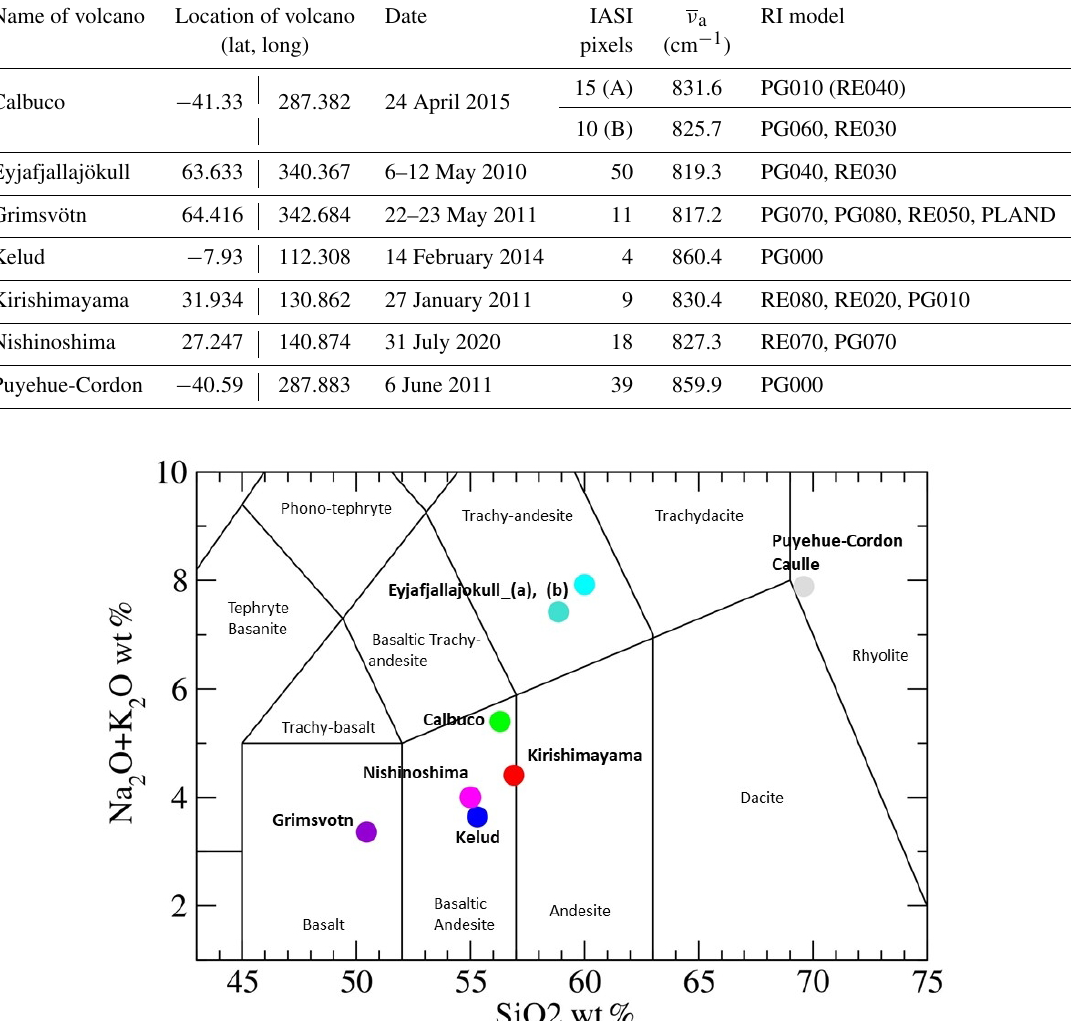
Figure 7. Total alkali–silica (TAS) diagram based on ash and pumice samples of the volcanos featured in Table 2. SiO 2 and Na 2 O + K 2 Owt% values for each volcano were obtained from the literature as follows: Calbuco values are from Deguine et al. (2020); Eyjafjalla- jökull and Grímsvötn values are from Reed et al. (2018) and Prata et al. (2019), respectively; Kelud values are from Maeno et al. (2019); Kirishimayama values are from https://www.gsj.jp/hazards/volcano/kirishima/2011/works-index.html (last access: 18 January 2022); Nishi- noshima values are from https://www.data.jma.go.jp/svd/vois/data/tokyo/STOCK/kaisetsu/CCPVE/shiryo/147/147_2-2.pdf (last